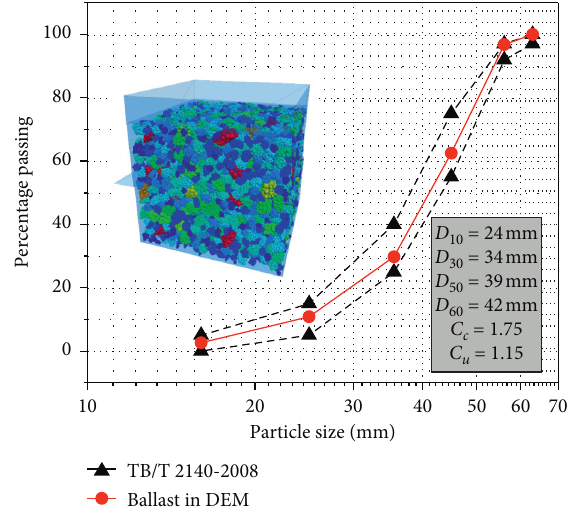
Figure 4: The size distribution of ballast aggregates in DEM.